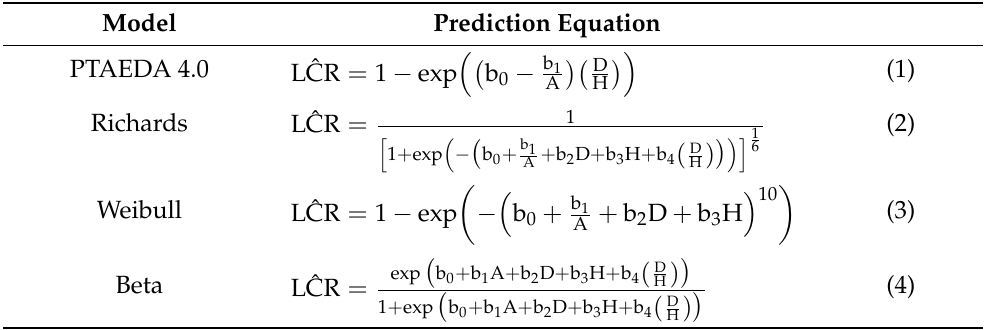
Table 2. Models and equations for predicting live crown ratio of loblolly pine trees used in this